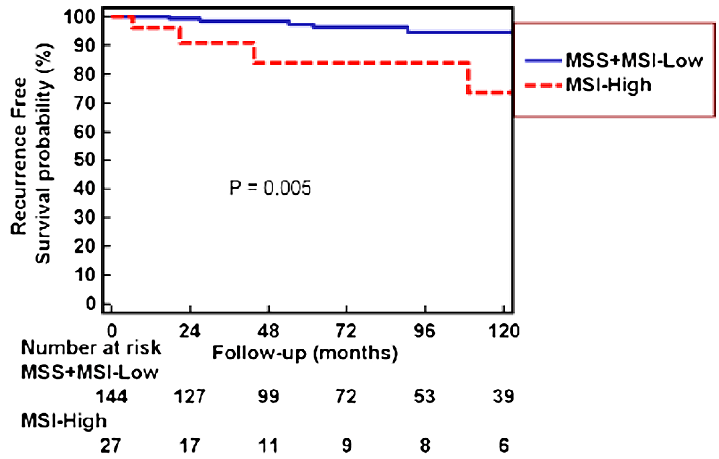
Fig. 2. Survival curve of the FIGO 1 endometrioid endometrial cancer according to MSI-status. (Colors are visible in the online version of the article;